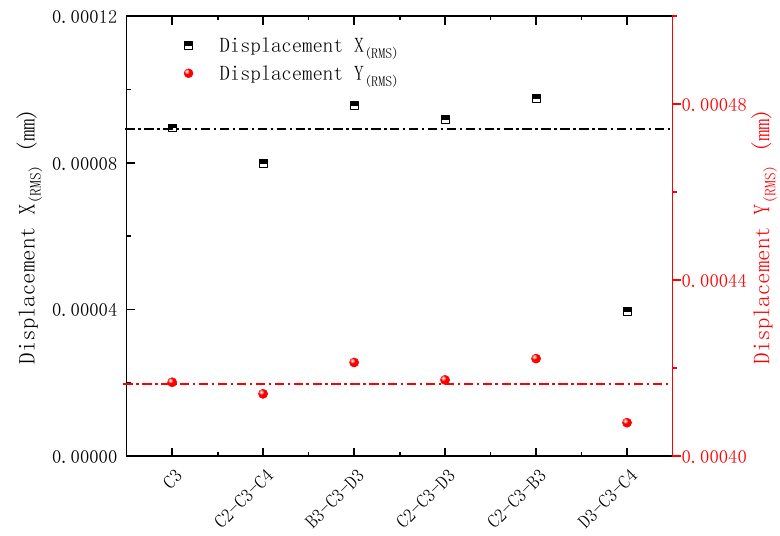
Figure 15. Axial and radial displacement comparison of C3.